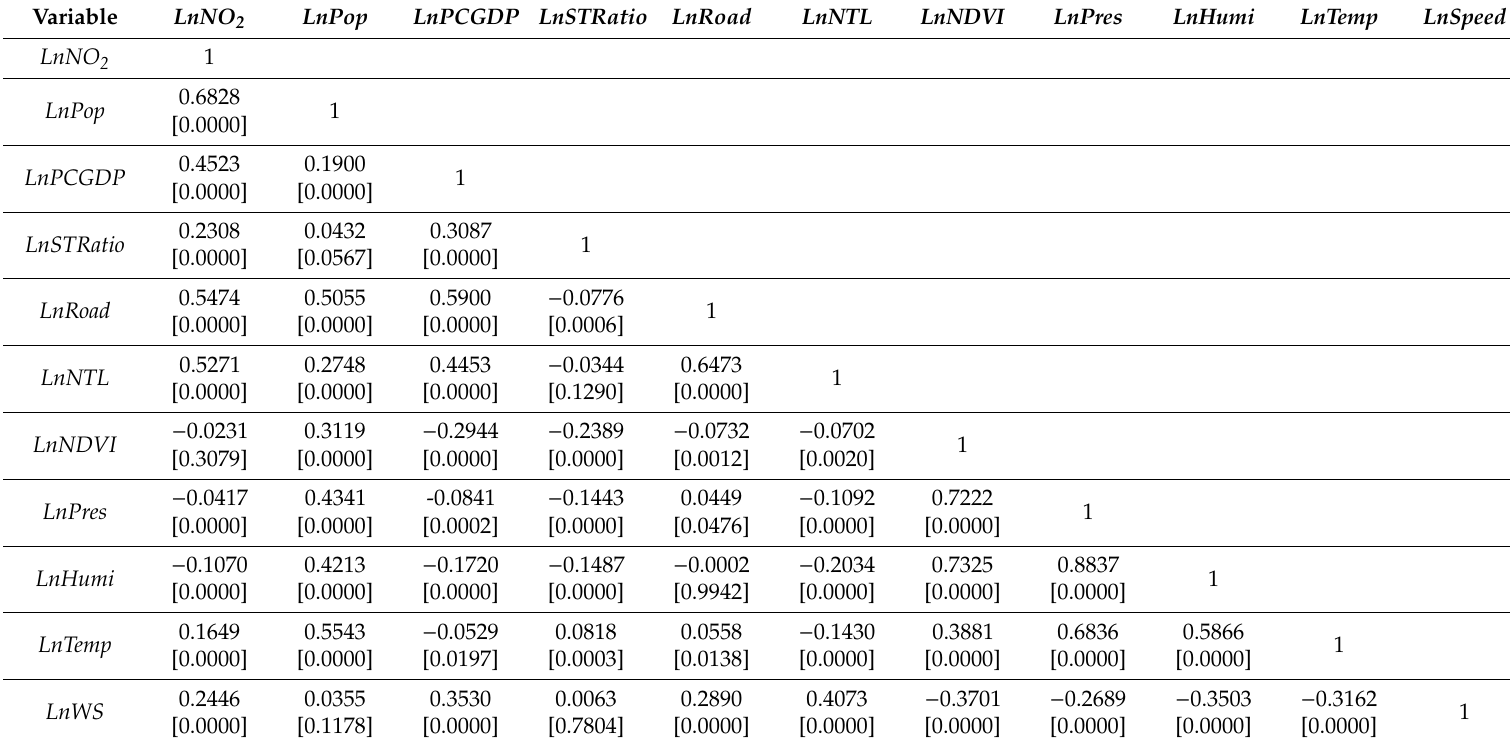
Table 2. Pearson correlation coe ffi